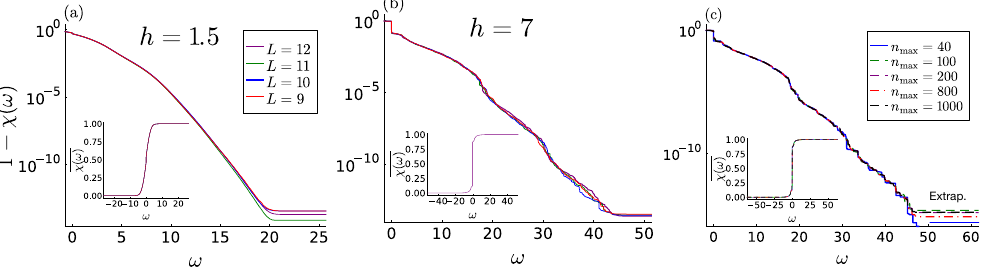
Figure 4: (a) The disorder-averaged cumulative spectral function 1 − χ ( ω ) in the ergodic regime h = 1.5 for several system sizes L . (b) Same as (a) but in the MBL regime h = 7. (c) The disorder-averaged cumulative spectral function 1 − χ ( ω ) from the extrapolated b with several Krylov cutoff order n . Insets: The disorder- n max averaged cumulative spectral function χ ( ω ) . Note that the flattening of 1 − χ ( ω ) at the high frequency in all of the figures is due to the numerical round-off